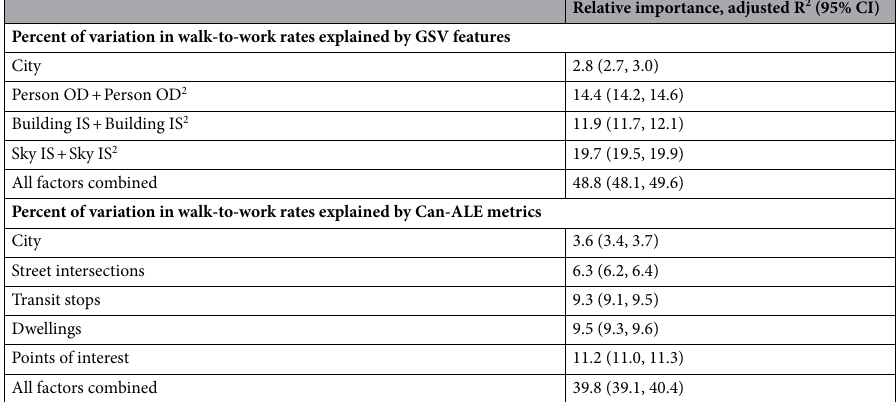
Table 3. Relative importance GSV features, Can-ALE metrics for log-transformed walk-to-work rates, all cities combined. The R 2 was calculated from linear regression models that included the variables indicated. The 95% confidence intervals of the R 2 increments were estimated by sampling with replacement using 1000 bootstrap replicates. OD object detection, IS image segmentation, and CI confidence interval.